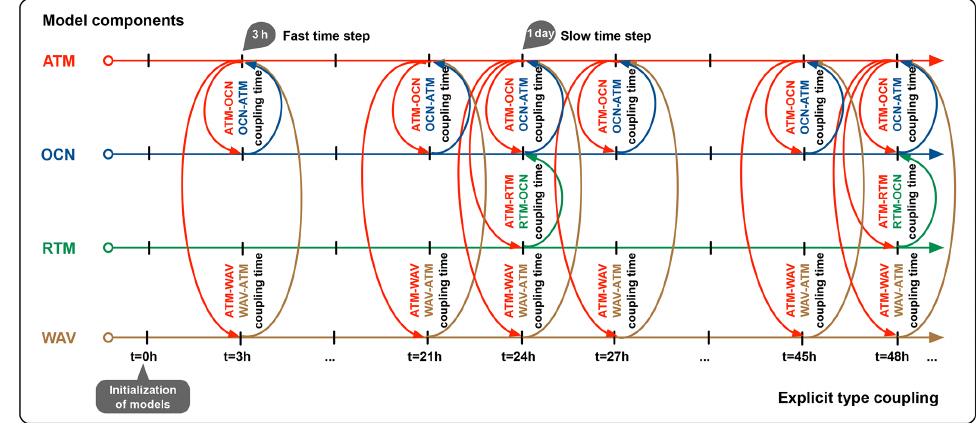
Figure 2. The run sequence of model components in the case of explicit type coupling. In this case, the fast coupling time step is used for the interaction between the atmosphere, ocean and wave components. The slow coupling time step is only used to interact with the river-routing component.